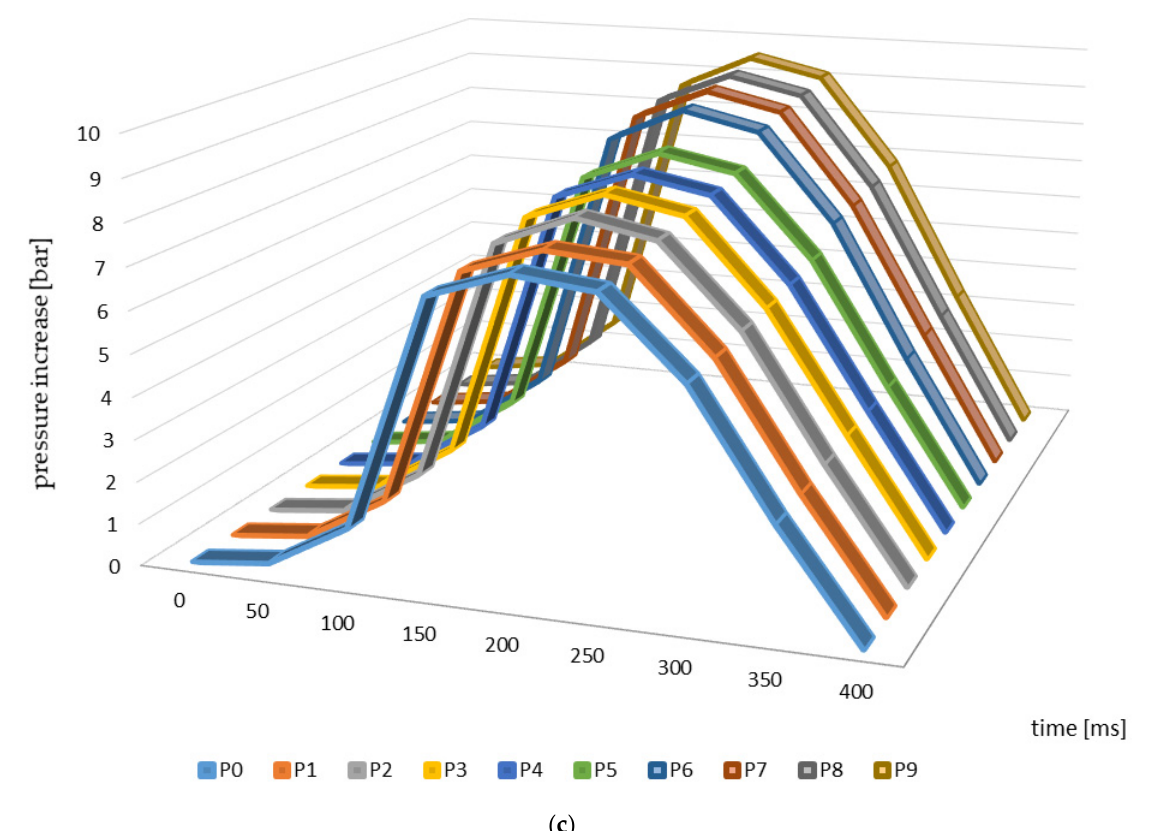
Figure 3. Explosion pressure curves identified for the branches and biochar samples (( a )—apple, ( b )—cherry, ( c )—pear).